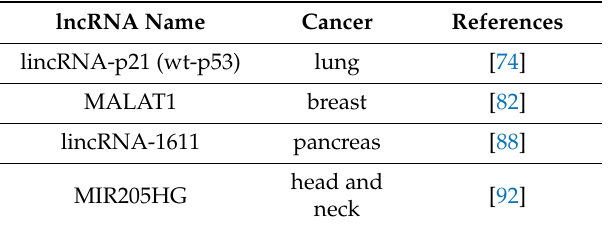
Table 3. Long non coding RNAs regulated by gain of function